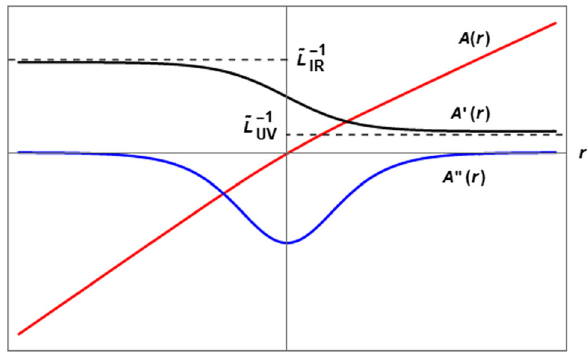
Fig. 1 The red, black and blue curves represent the behavior of the solution (3.11) and its first and second derivatives, A , B < 0. This solution asymptotically goes to the AdS solution in the UV/IR